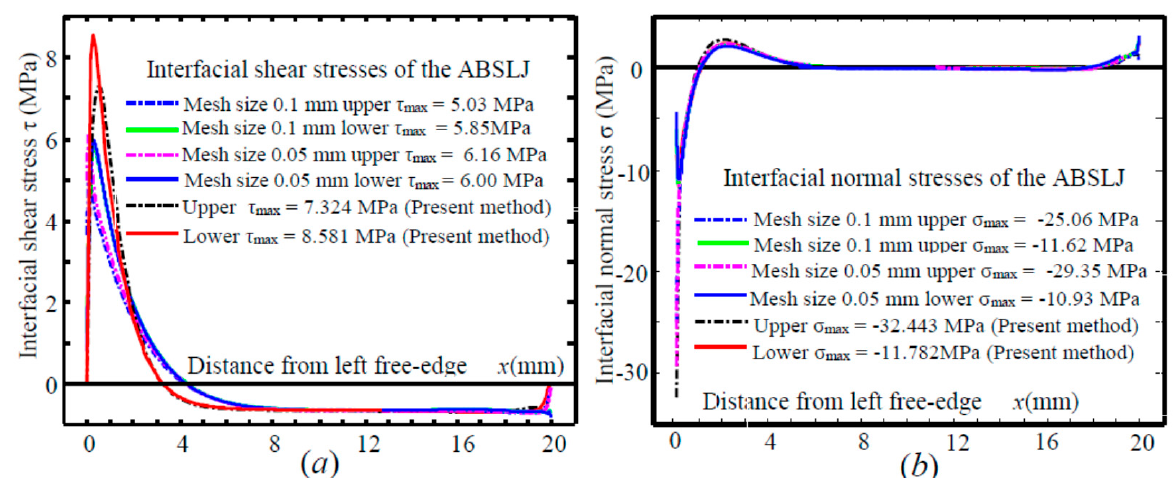
Figure 4. Validation of the stress-function variational method for determining the interfacial shear and normal stresses in an ABSLJ subjected to a shear traction: ( a ) Interfacial shear stress and ( b ) interfacial normal stress at the upper and lower surfaces of the adhesive layer, respectively (In each case, the first four curves are predicted by FEA with indications of the corresponding peak stress values).